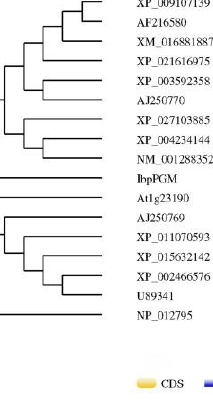
Figure 2. Phylogenetic and gene structure analyses of IbpPGM and PGMs from other species using